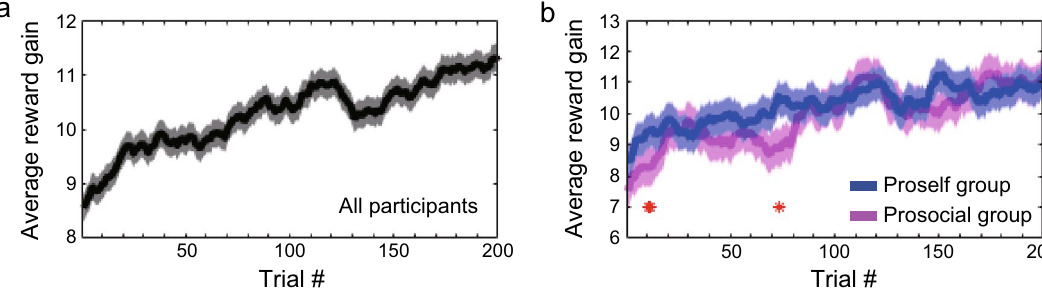
Figure 3. Comparing reward gain between the proself and prosocial groups. ( a ) Moving averages of the reward amount for all participants, where shaded error bar represents standard error of the mean (SEM). ( b ) Moving averages of the reward amount for the proself and prosocial groups; Blue indicates the proself group. Magenta indicates the prosocial group. Asterisks indicate data points where there was a significant difference ( p < 0.05) between the proself and prosocial groups. Significant differences were found in trials #11, #12, and